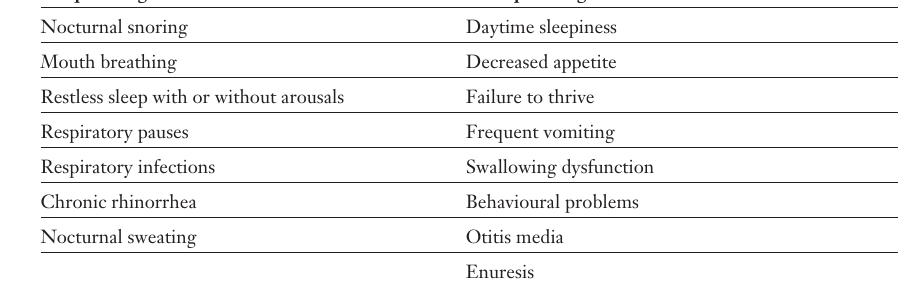
Table 2 Diagnostic criteria of